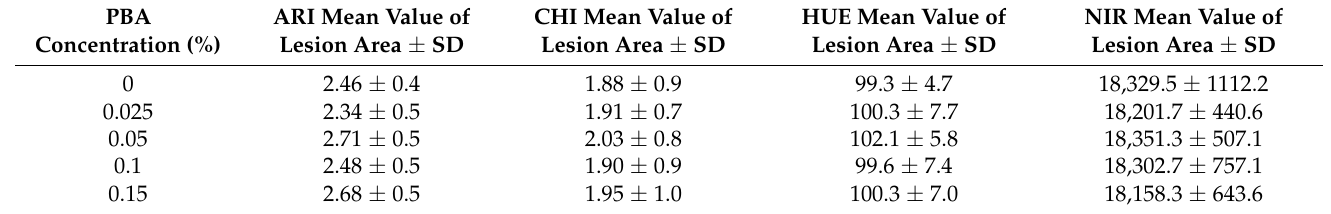
Table 4. Effect of PBA on some physiological parameters of tomato plants 15 days post-application.